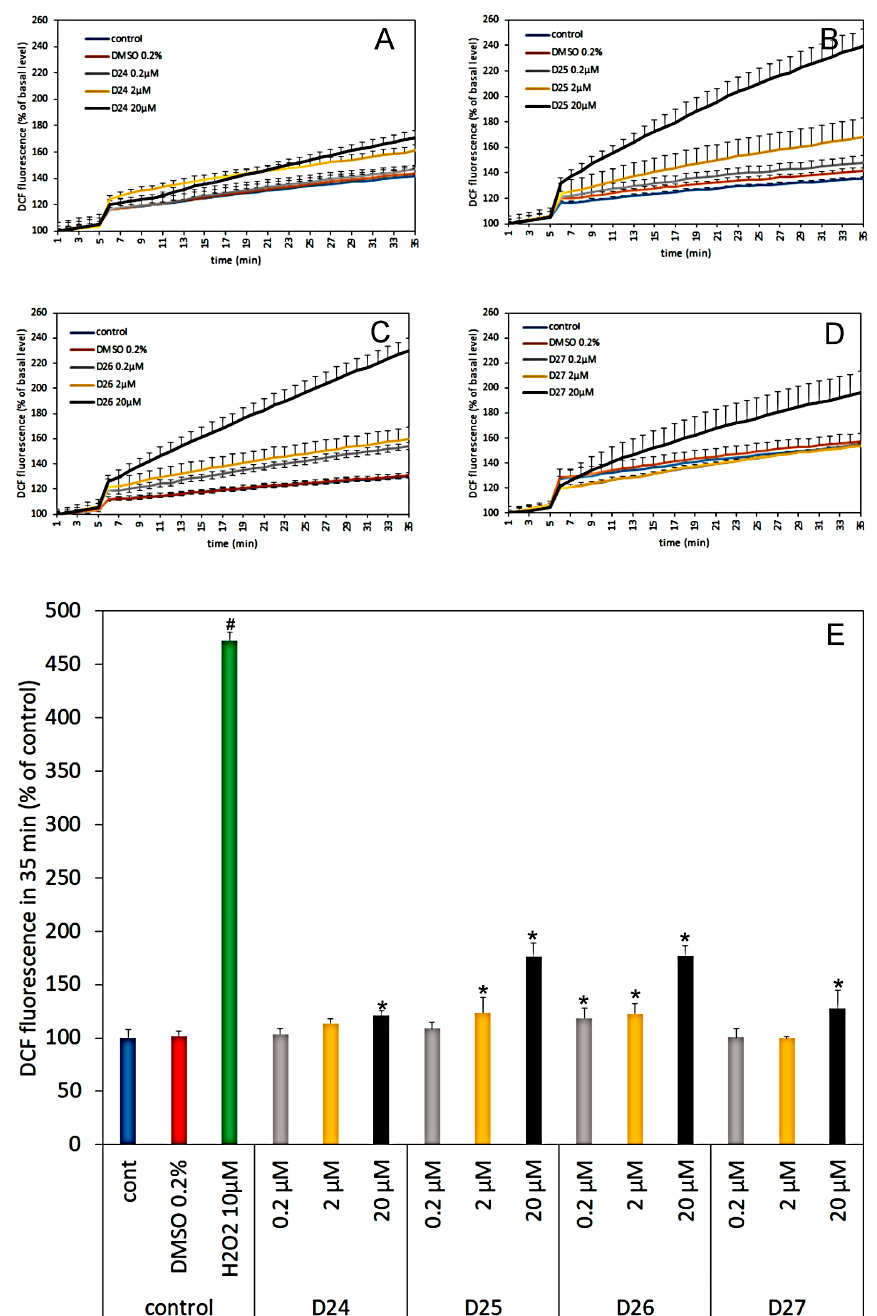
Figure 5. The effect of different concentrations (0.2, 2 and 20 µM) of dendrimers D24–D26 ( A – D ) on reactive oxygen species (ROS) production in CGC during 30 min incubation in Locke 5 medium. Fluorescence of basal line: from 1st to 5th min was recorded every 1 min. Vehicle (0.2% DMSO), dendrimers or positive control of ROS formation (H 2 O 2 10 µM) (not presented on Figure 5 A–D) were added after 5th min. of measurement. The line from 6th to 35th min: changes in 2’, 7’-dichlorofluorescein (DCF) fluorescence recorded every 1 min. Results are presented as mean (± SD) from 4 repetitions compared to their basal level (F/Fo %). Figure 5E shows differences in DCF fluorescence at the end of experiments. Results are presented as mean (± SD) from 4 repetition compared to control or vehicle (0.2 % DMSO). *Result statistically significant vs. DMSO and # vs. control, p < 0.05, one-way